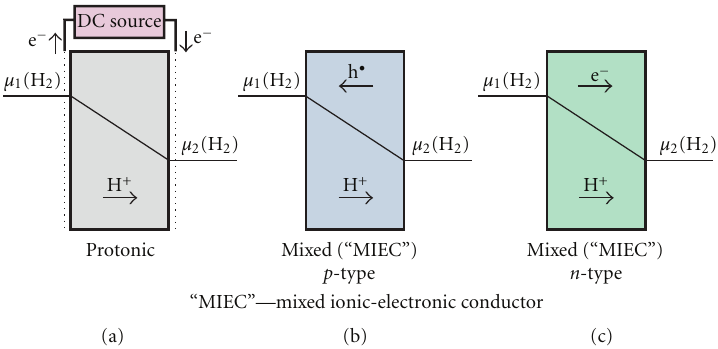
Figure 1: Schematic diagrams of electrochemical hydrogen separators: (a) hydrogen pump, (b, c) hydrogen conductive membranes.